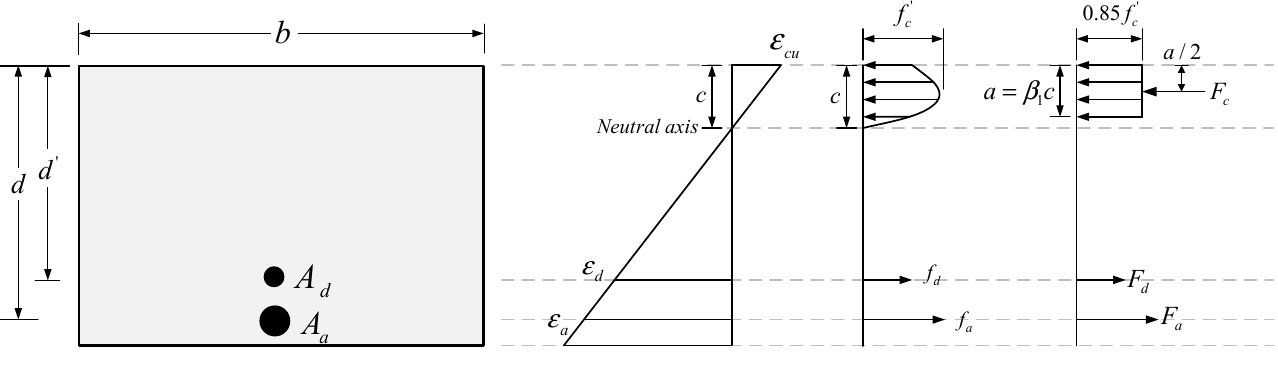
Figure 6. Section analysis of composite decks.